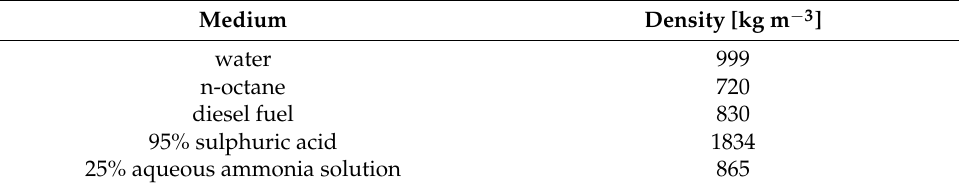
Table 13. Materials of droplets used in calculations and their